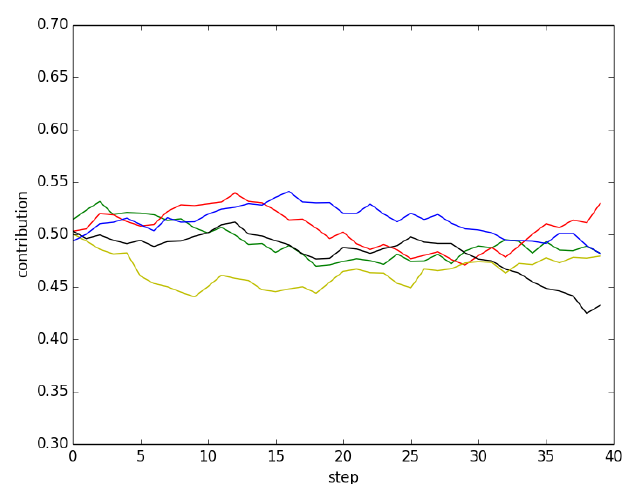
Figure 8. Average contribution during time in five independent simulations in which agents are trend-following according to the rules of the group average-based model (see Table